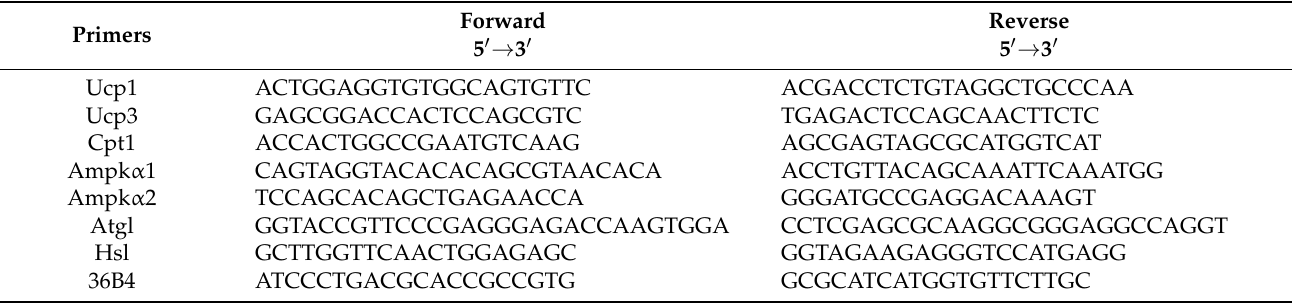
Table 3. Primers for gene